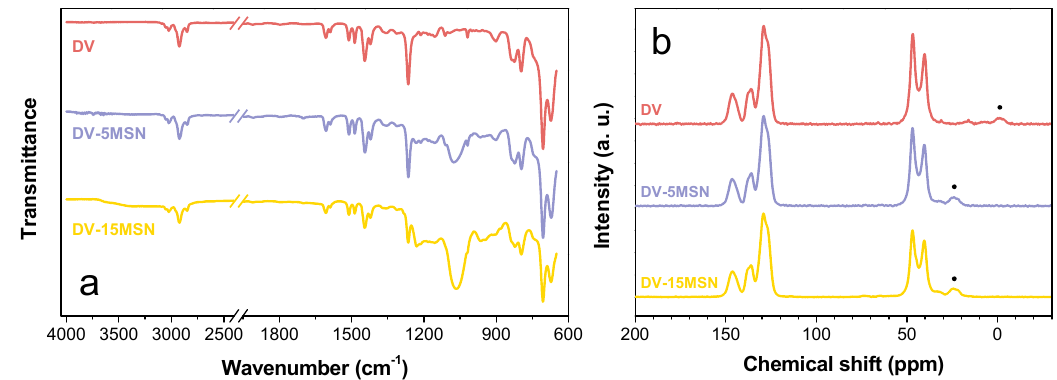
Figure 2. FTIR ( a ) and NMR ( b ) spectra of DV and DV-xMSN. Spinning sidebands are marked by dots in b.